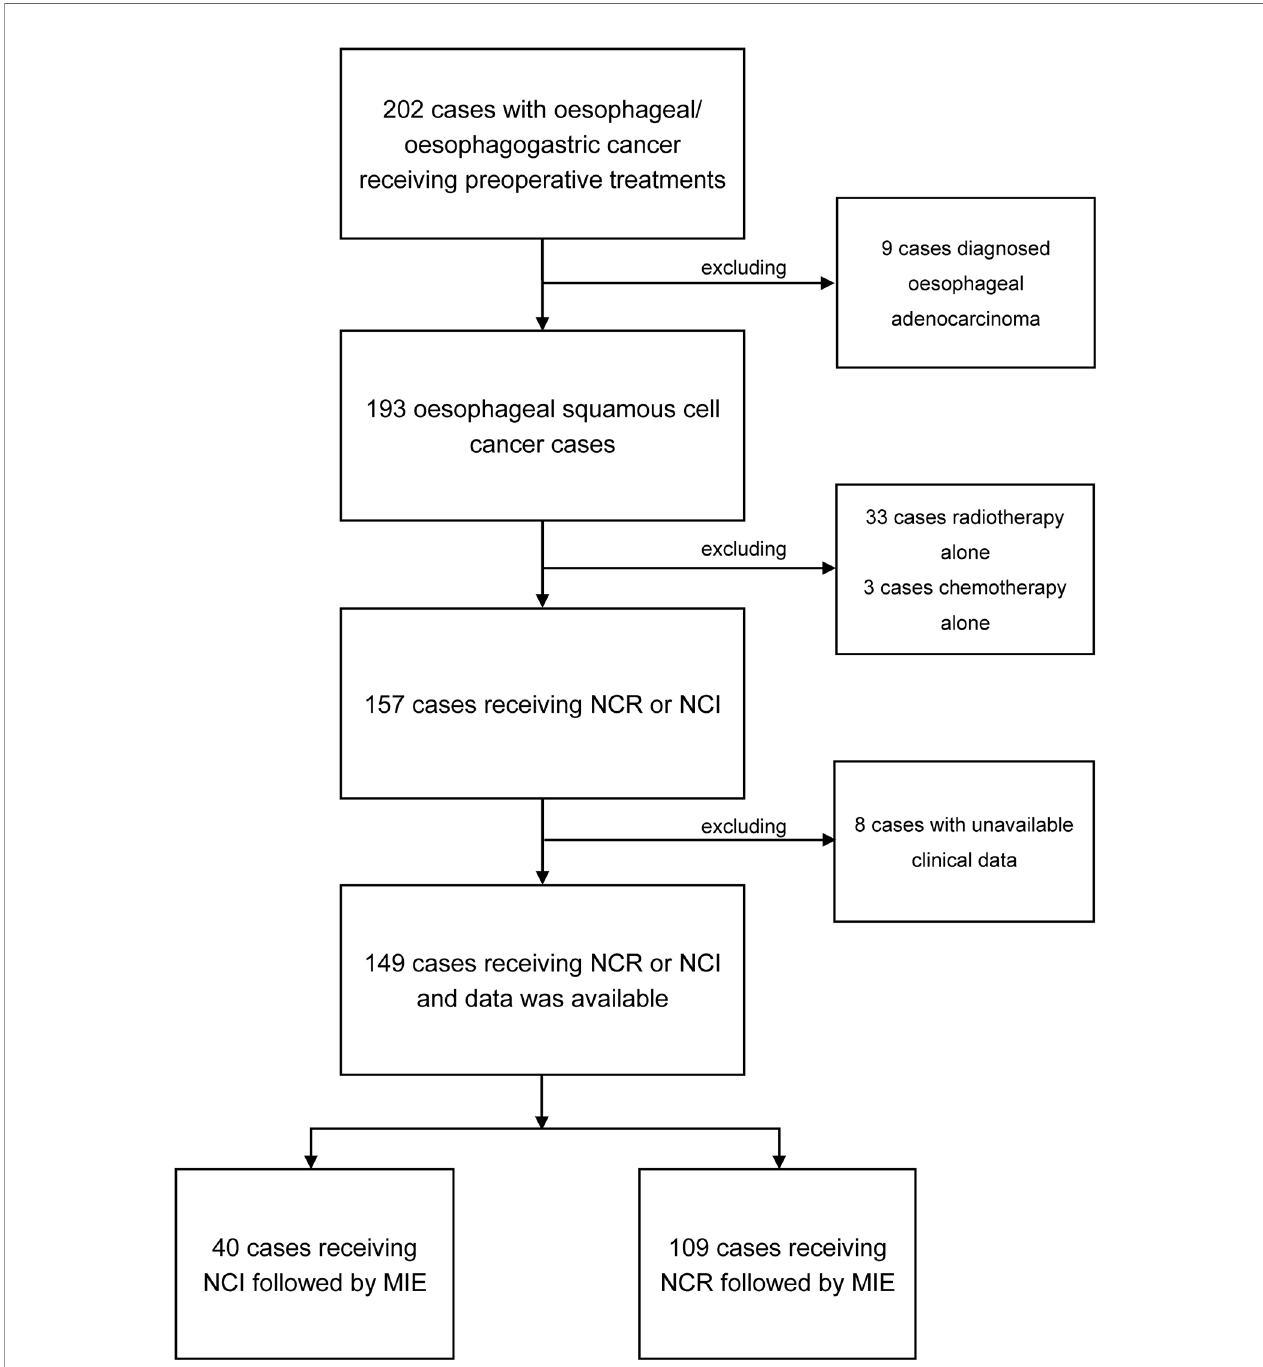
FIGURE 1 | Flow chart for enrolling